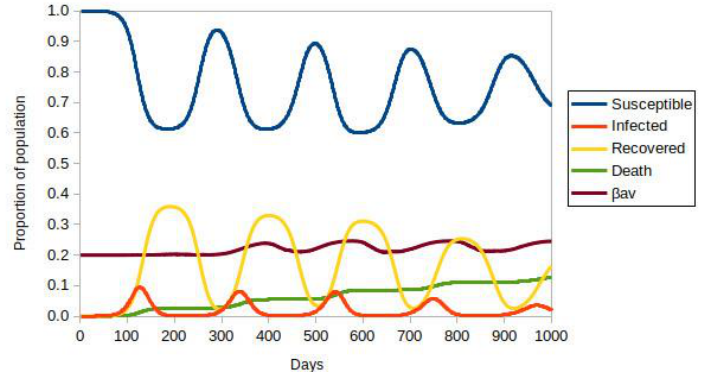
Figure 2. ABM-SIR dynamic of COVID-19 (i.e., Susceptible-Infected-Recovered Agent-Based model) evolution over 1000 days with a social isolation of 40%, adjusted for the initial population of ∼ 8.75 × 10 5 individuals. There is no vaccination. Each color represents a population group, defined in the legend. The value of β av is the average for all infected people.